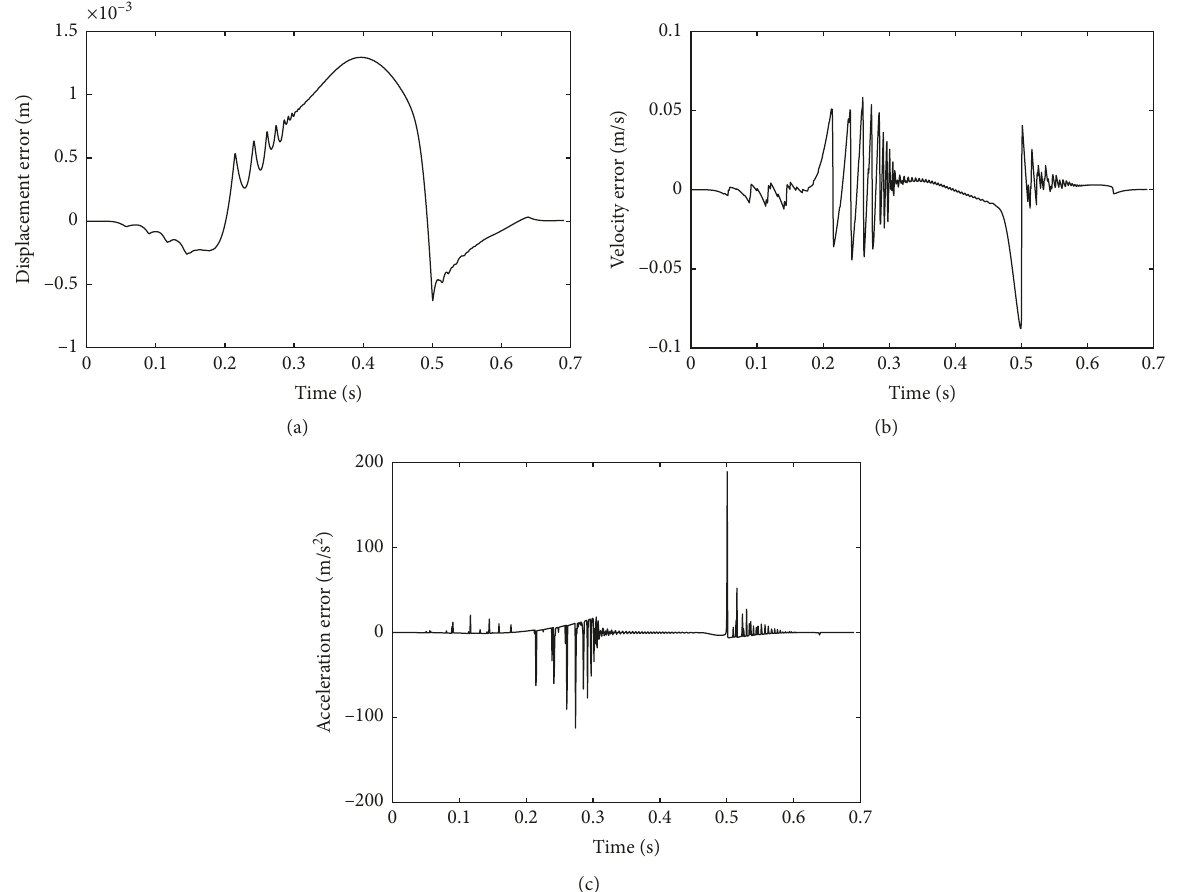
Figure 6: Kinematics characteristics error of slider: (a) displacement error of slider; (b) velocity error of slider; (c) acceleration error of slider.